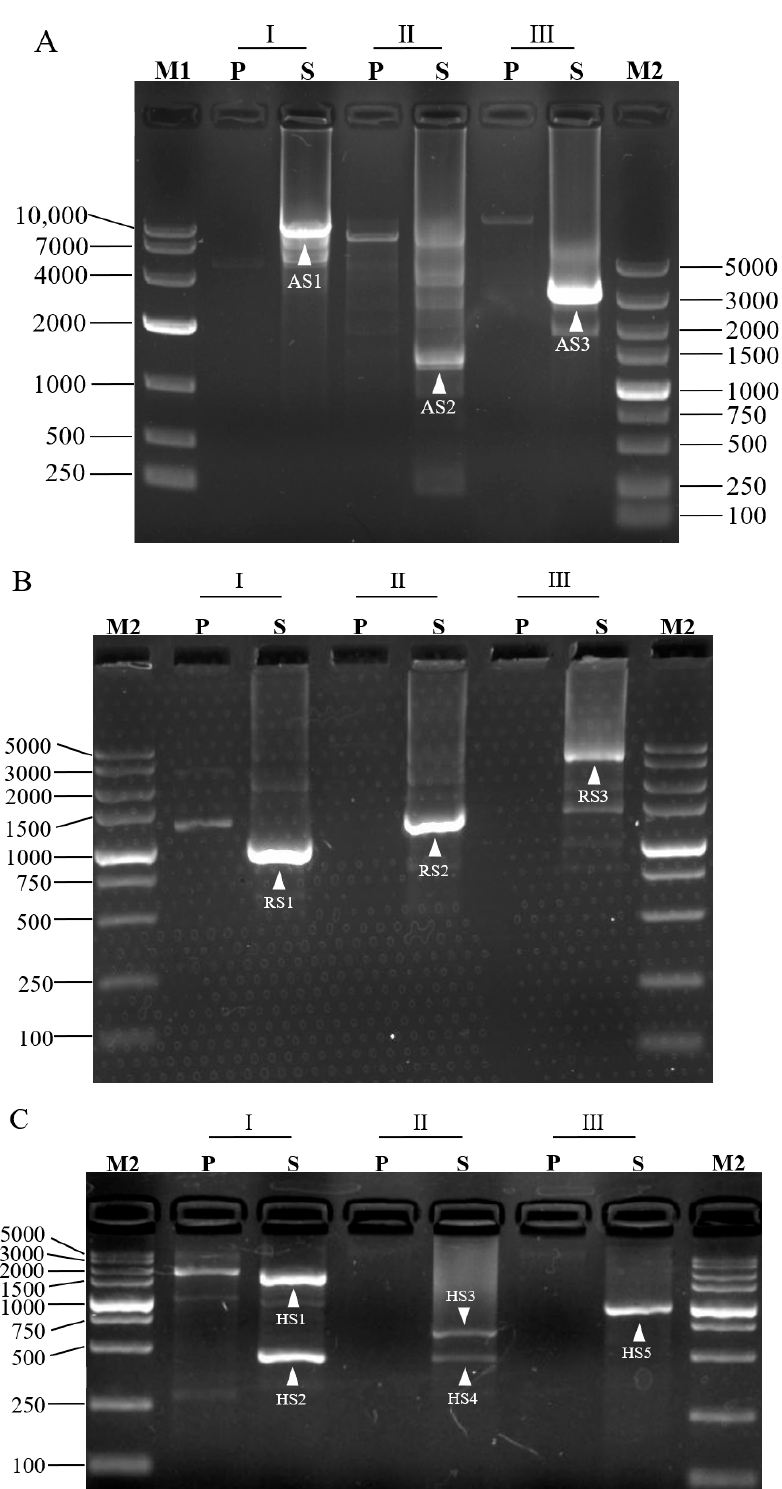
Figure 2 . Probing upstream of gadA gene ( A ), downstream of gadR gene ( B ) of L. brevis CD0817, and downstream of hyg gene ( C ) of rice. Marks I, II, and III denote the three parallel sets of 3SP-PCRs in each walking experiment. P: primary PCR; S: secondary PCR; M1: DNA 10,000 Marker (TaKaRa, Dalian, China); M2: DNA 5, 000 Marker (TaKaRa, Dalian, China). The fragments AS1-AS3, RS1-RS3, and HS1-HS5 are the secondary PCR amplicons of gadA, gadR, and hyg, respectively.